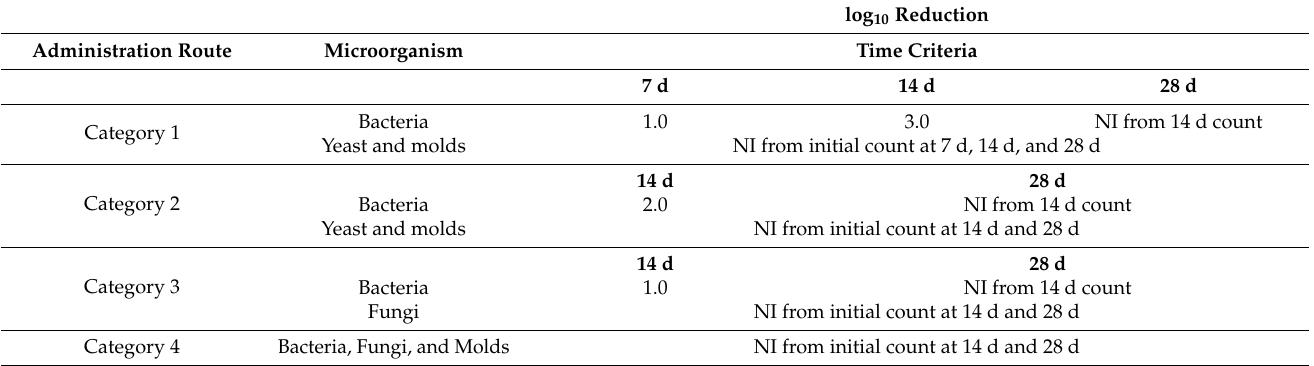
Table 4. USP43-NF38 criteria for antimicrobial efficacy tests depending on the administration routes. The log 10 reduction represents the antimicrobial efficacy that must be achieved to reach efficacy standards. The values differ depending on the administration route